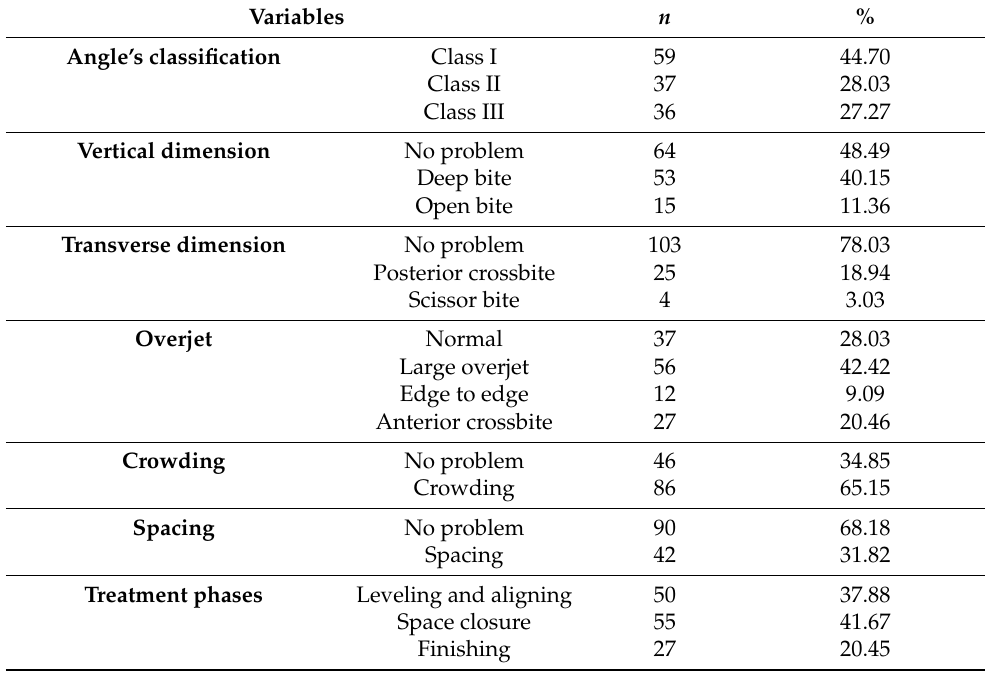
Table 3. Patient information of the research